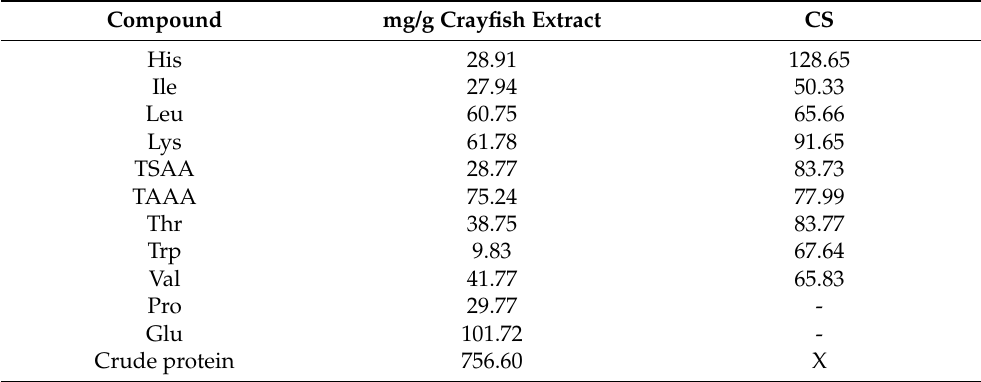
Table 2. Amino acid (AA) content of F. limosus extract expressed in mg/g extract and chemical score (CS) of each